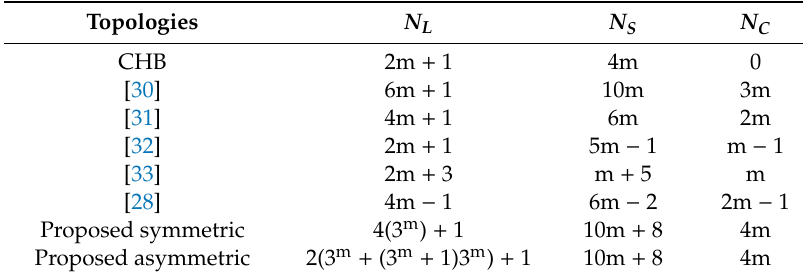
Table 6. Comparison with other extended. Structure of